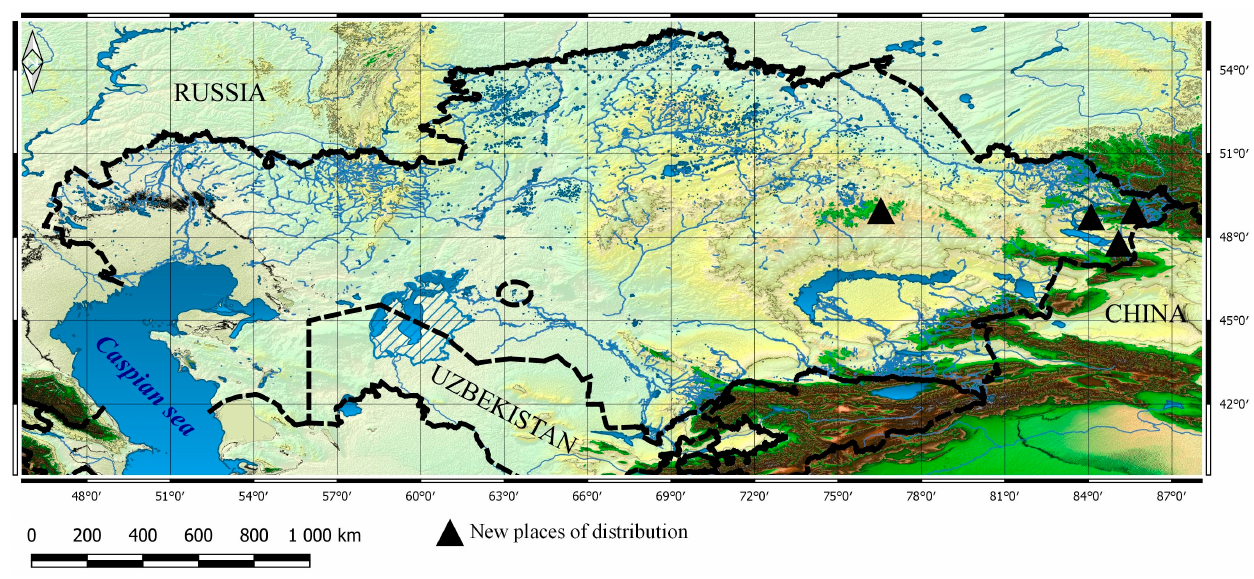
Figure 2. Distribution of Dactylorhiza fuchsii subsp. hebridensis (Wilmott) Soó (L.) Soó in Kazakhstan.